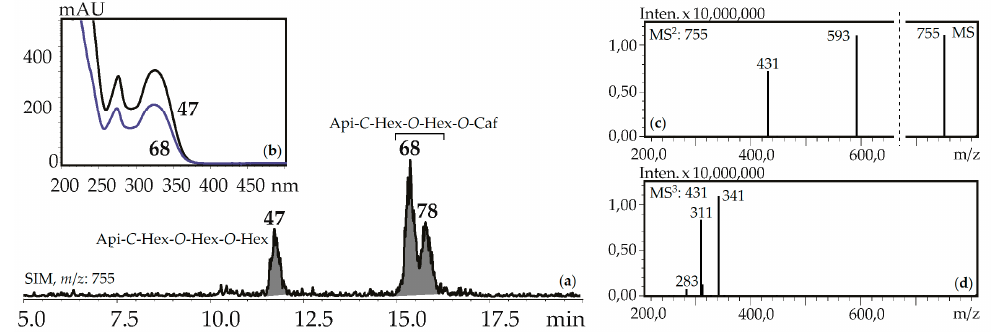
Figure 7. ( a ) HPLC-ESI-MS chromatogram of G. gelida herb extract in SIM-mode ( m / z 755). ( b ) UV spectra of compounds 47 and 68 . ( c ) MS and MS 2 spectra (negative ionization) of compound 68 . Api- C -Hex- O -Hex- O -Hex—apigenin- C -hexoside- O -hexoside- O -hexoside (isovitexin-2”,4”-di- O - glucoside), Api- C -Hex- O -Hex- O -Caf—zone of isomeric apigenin- C -hexoside- O -hexoside- O -caffeates.